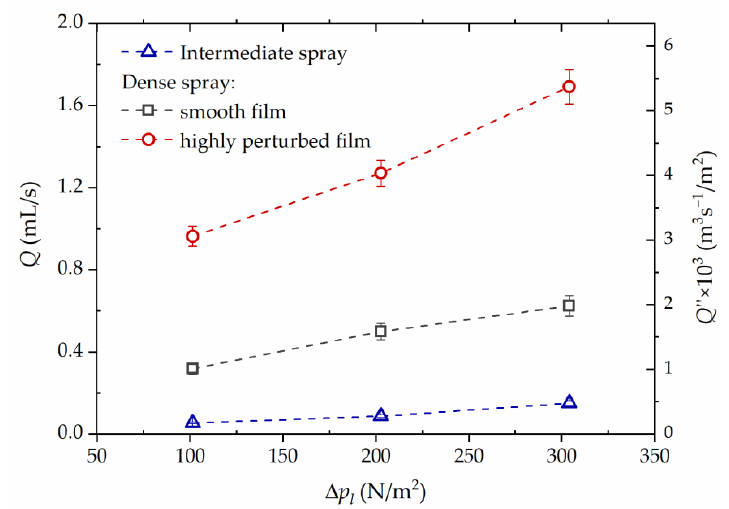
Figure 2. Liquid flow rates for the studied spray cooling regimes. The error bars are presented for the Q values.